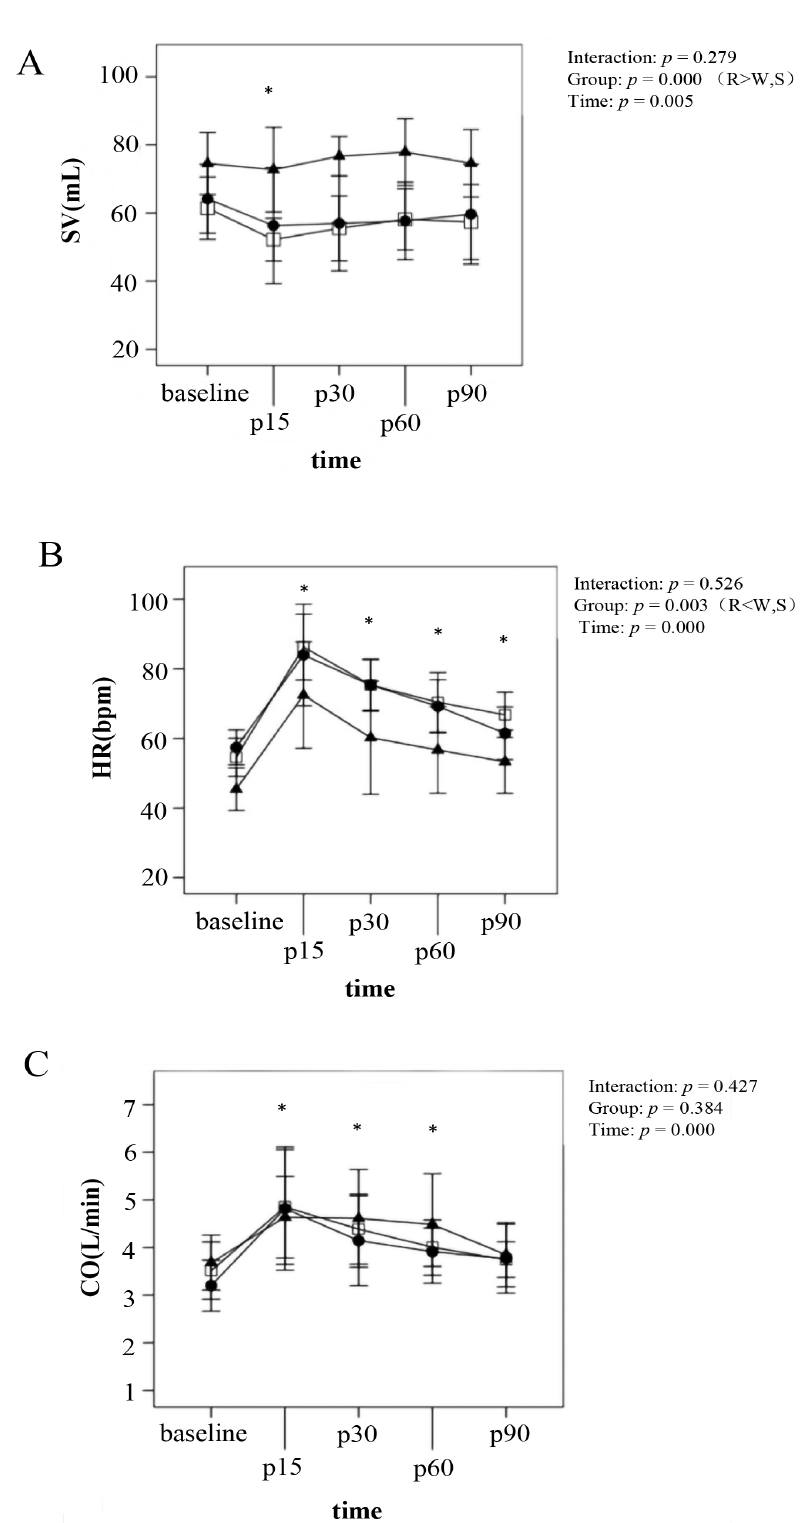
Fig. 2. Stroke volume (SV), heart rate (HR), and cardiac output (CO) before and after exercise. Data are presented as means ± standard deviations. □ , Sedentary controls (S); • , Weightlifters (W); and ▲ , Runners (R). * p < 0.05 compared with baseline. p15, p30, p60, and p90; 15, 30, 60, and 90 min after exercise,